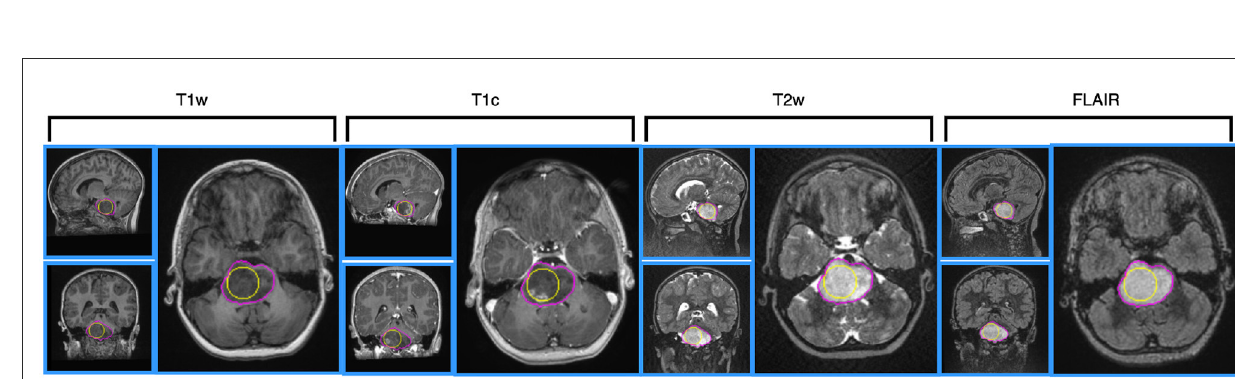
FIGURE1 Illustration of MRI data for a 4 year-old patient, having H3.1 and ACVR1 mutations, having no TP53 mutation. MRI data are shown after intensity normalization using the hybrid white stripe method. From the left side to the right side: T1w, T1c, T2w and FLAIR images, using for each modality. The contours of the sphere used for computing intensity and texture radiomic features inside the tumor are outlined in yellow color on each view. The contours of the tumor used for computing shape features are outlined in pink